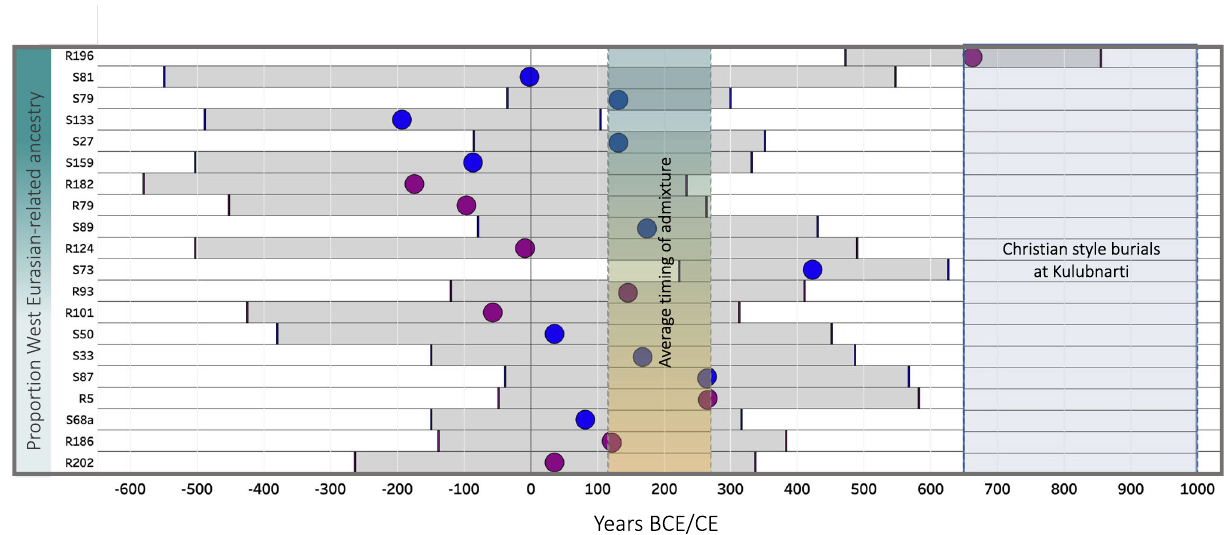
Fig. 4 Estimated timing of admixture for 20 Kulubnarti Nubians with direct 14 C dates. Individuals are ordered from most to least amount of West Eurasian-related ancestry; maroon and blue circles represent individuals buried in the R and S cemeteries, respectively; location of the circles indicates mean estimate of admixture using DATES and determined with calibrated 14 C date, gray horizontal bars indicate 95% CI of admixture date estimate in years BCE/CE. 95% CI of the average timing of admixture at Kulubnarti (111 – 265 CE) and dates of use of Kulubnarti R and S cemeteries (~650 – 1000 CE) shown in shaded areas. Data in Supplementary Data